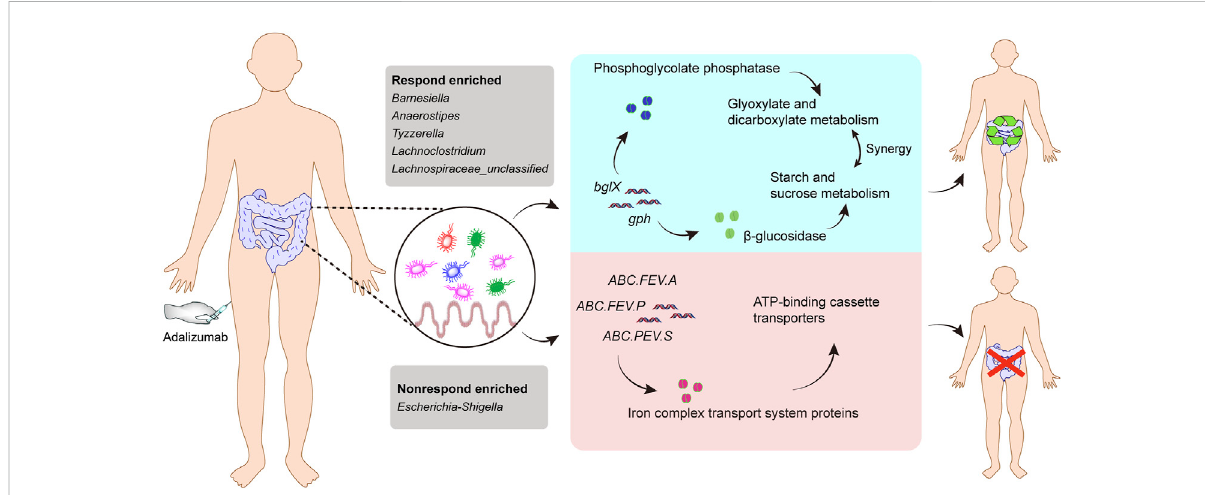
FIGURE 7 Gut microbiome – associated mechanism of ADA therapy response. The abundance of the fi ve genera ( Barnesiella , Anaerostipes , Tyzzerella , Lachnoclostridium , and Lachnospiraceae _ unclassi fi ed ) were increased in the responsive group when compared with their nonresponsive counterparts, while a higher abundance of pathogenic bacteria ( Escherichia – Shigella ) was observed in the nonresponsive group than in its responsive counterpart. The gene bglX encoding β -glucosidase and gph encoding phosphoglycolate phosphatase are both activated during ADA treatment, facilitating starch and sucrose metabolism and glyoxylate and dicarboxylate metabolism, respectively, thus contributing to ADA ef fi cacy synergistically.Conversely, theenrichmentofABC.FEV.A, ABC.FEV.P,and ABC.FEV.S,whichencode iron complex transportsystem proteins (i.e.ATP-bindingprotein,permeaseprotein,andsubstrate-bindingprotein,respectively),alleviatesADAresponseinpatientswithCD via thepathway of ABC